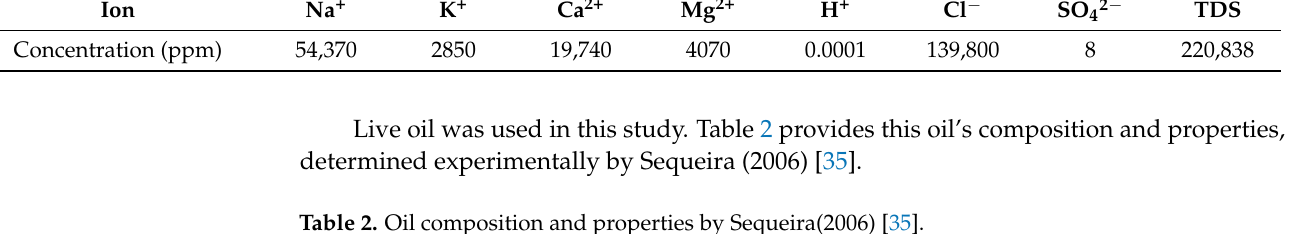
Table 2. Oil composition and properties by Sequeira(2006)